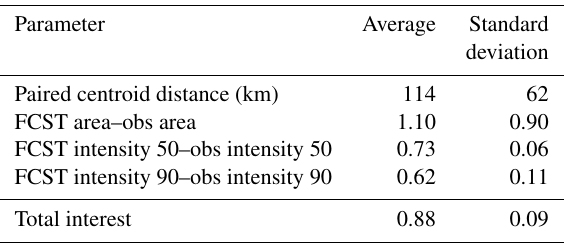
Table 1. Clusters pair statistics for the 12 members out of 17, show- ing significant values (above 0.8) of the total interest